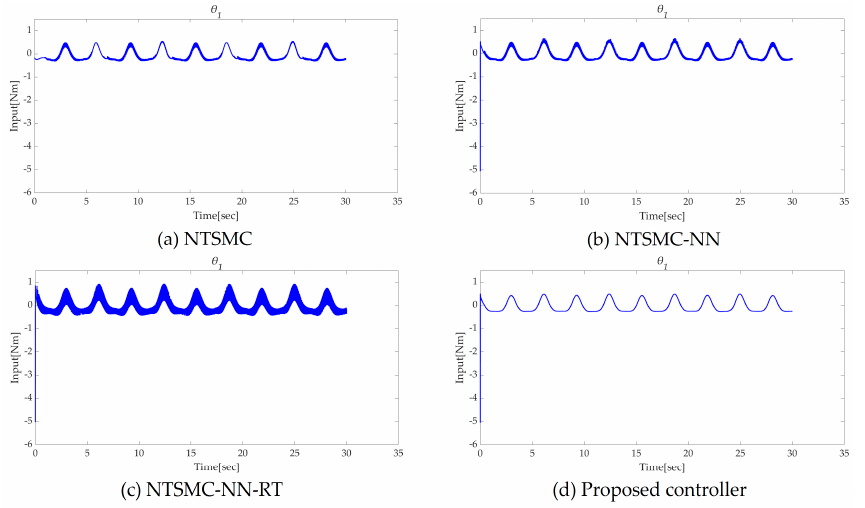
Figure 11. Proposed controller performance for continuous input.